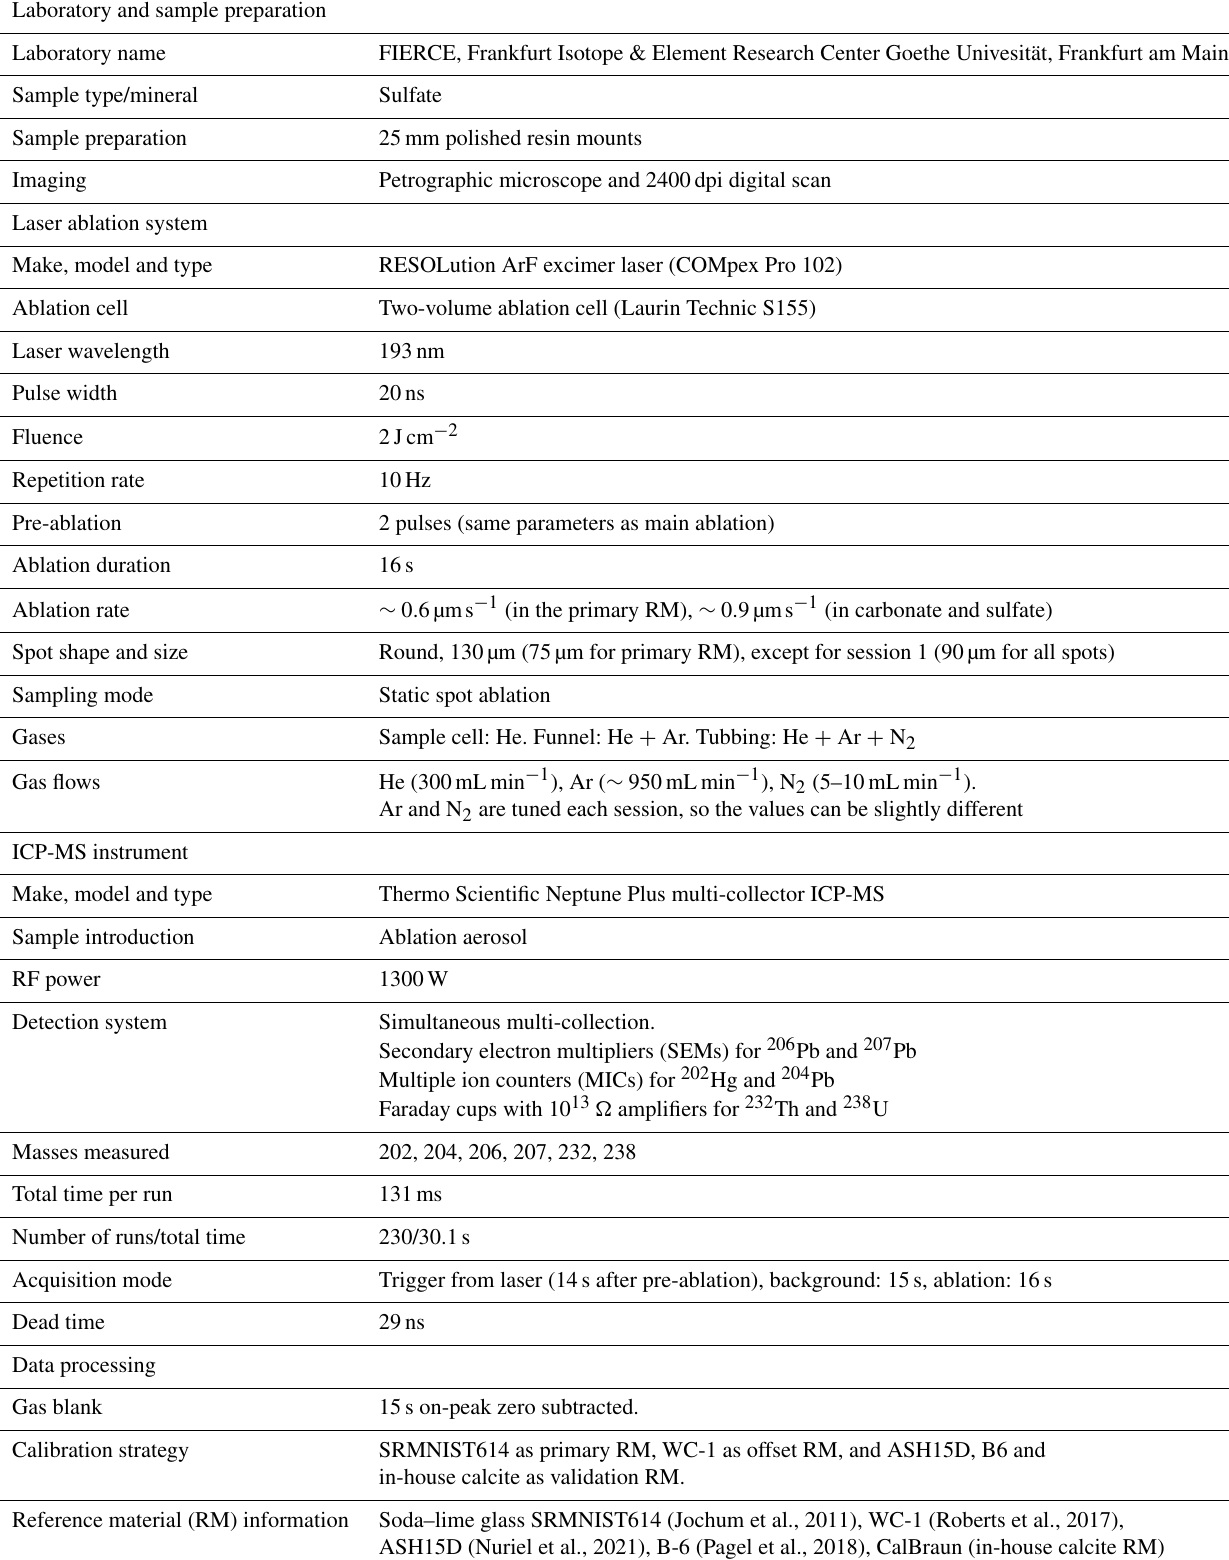
Table 2. LA-MC-ICP-MS U–Pb analysis procedure at Goethe University Frankfurt, FIERCE laboratory. Laboratory and sample